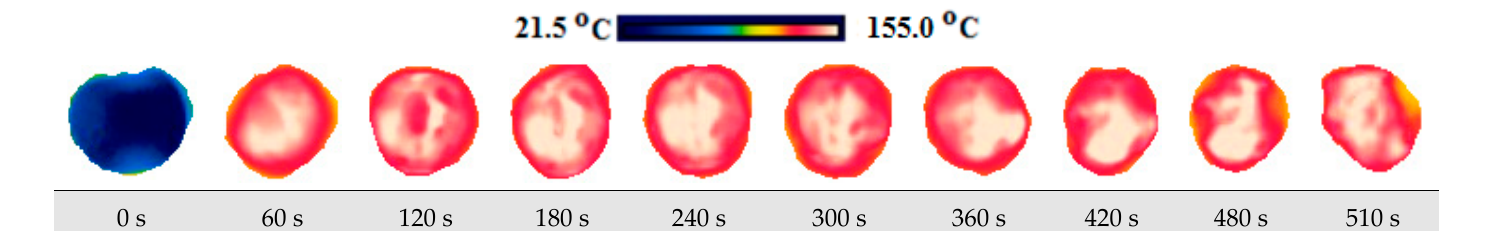
Figure 14. Thermal images of persimmon with 7 mm at 120 W .